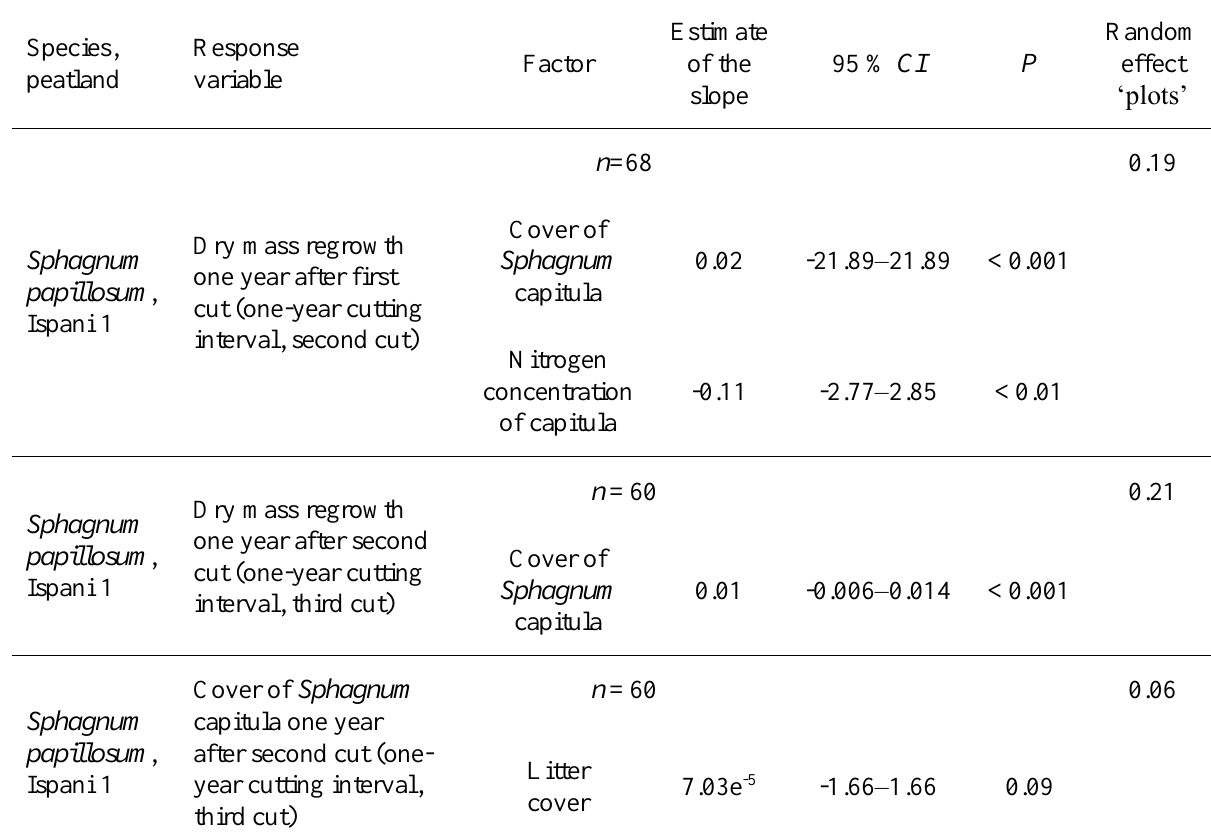
Table A4. Results of boosted generalised linear mixed modelling of the response variable dry mass regrowth of Sphagnum papillosum at Ispani 1 tested separately for the one-year cutting interval at second and third cut on site conditions (cover of Sphagnum capitula and litter (%), mean water table level (cm below Sphagnum surface), pH and EC of the interstitial water, element concentrations in Sphagnum capitula (N) and surface peat (N, P, K), and C/N quotient of surface peat). P and K concentrations and N/P and N/K quotients were included in the dataset for third cut. Results are also presented for the cover of Sphagnum papillosum capitula at Ispani 1 directly before the third cut, tested for litter cover in the one-year cutting interval. CI = confidence